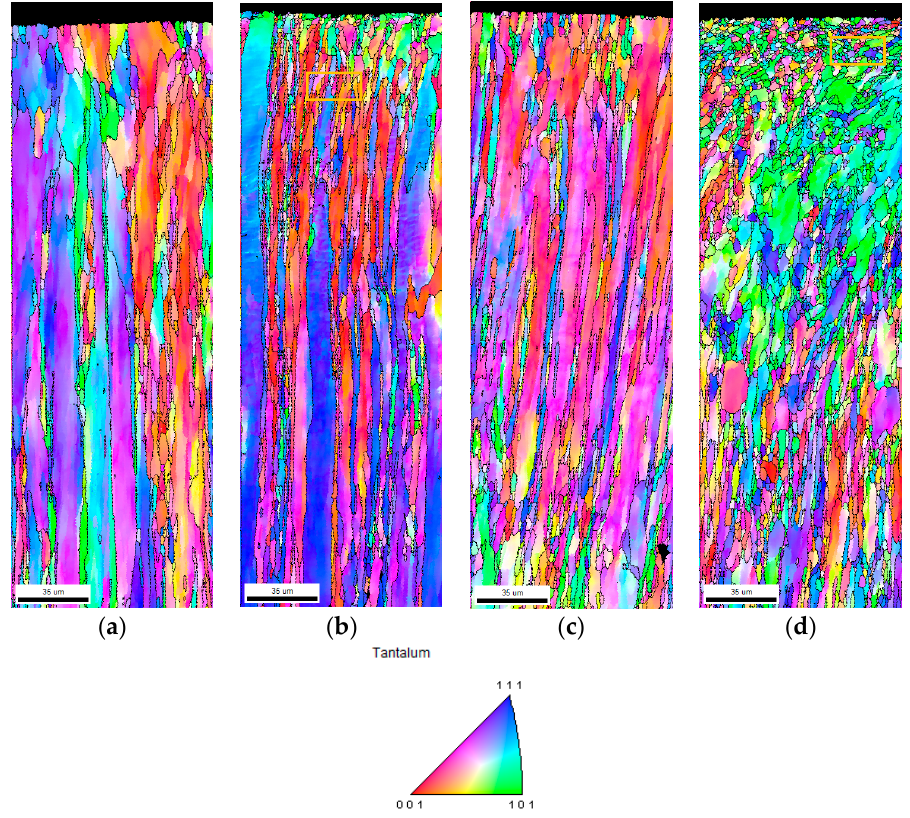
Figure 1. Cross-sectional electron backscatter diffraction (EBSD) Inverse Pole Figure (IPF) maps of the untreated ( a ), UNSM-treated at RT ( b ) and local heat treatment (LHT) without ( c ) and with ( d ) UNSM treatment at 1000 °C specimens.